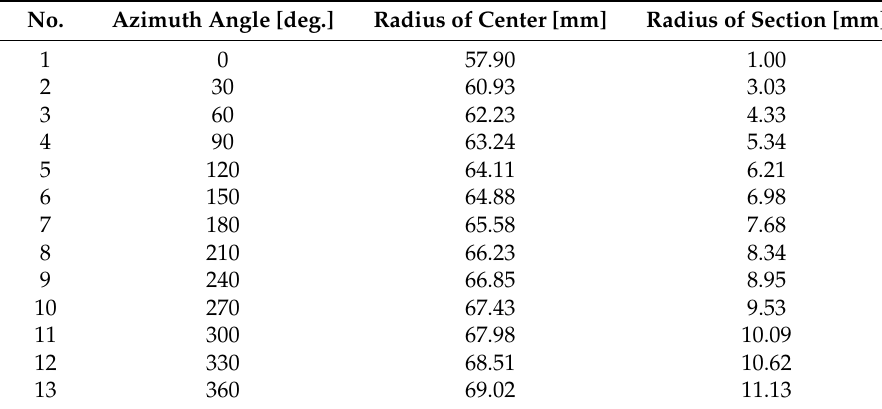
Table 5. Design dimensions of the turbine volute.